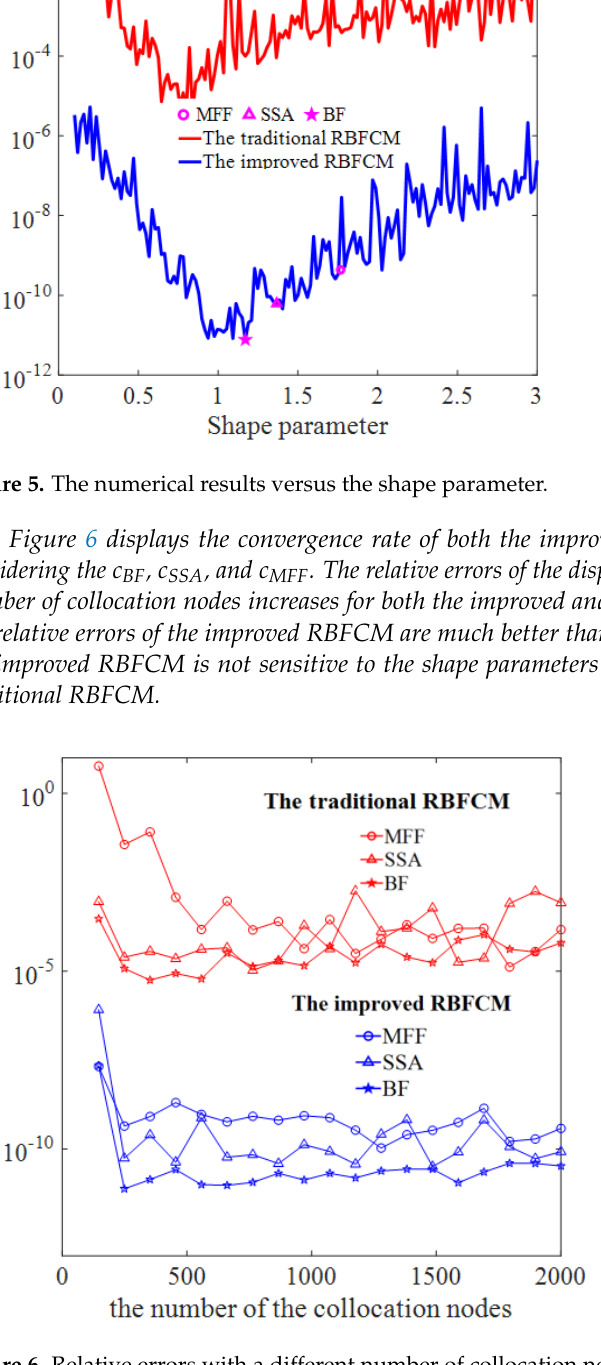
Table 1. The relative errors of the improved RBFCM with different R.